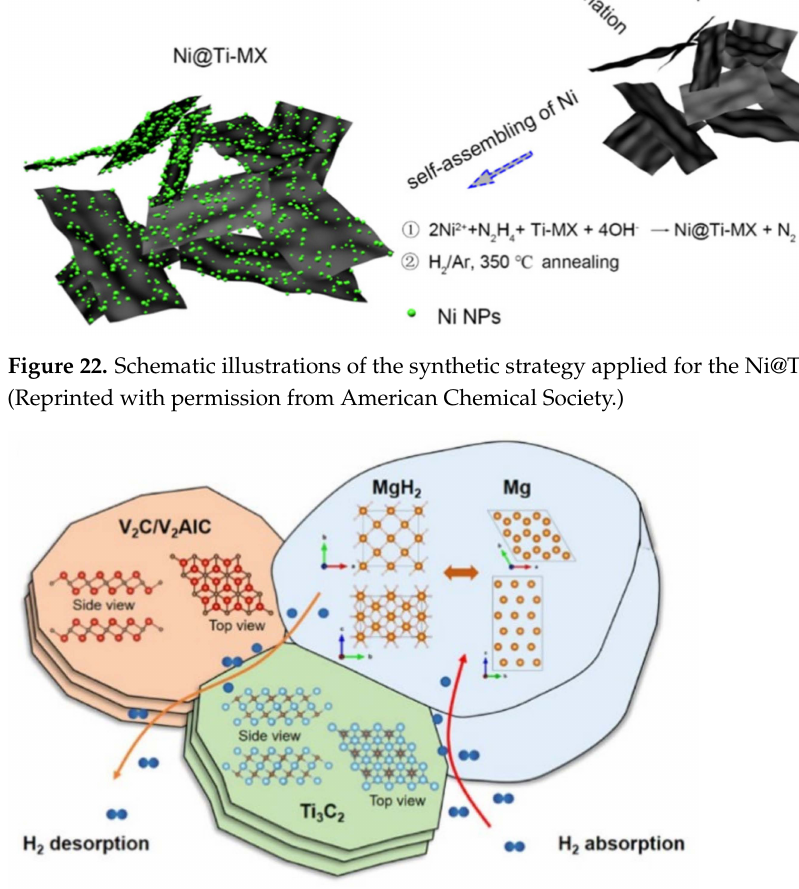
Figure 23. Schematic pictures showing the hydrogen desorption and absorption mechanisms of MgH 2 with the addition of V 2 C/Ti 3 C 2 [168]. (Reprinted with permission from the American Chemi- cal